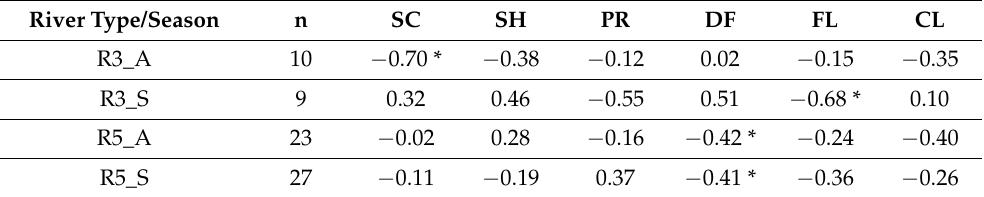
Table 2. Linear correlation coefficients between the degree of shading and abundance of each trophic groups for both river types and sampling season ( p < 0.05; n—number of cases). The (*) asterisk indicates the significant correlations.